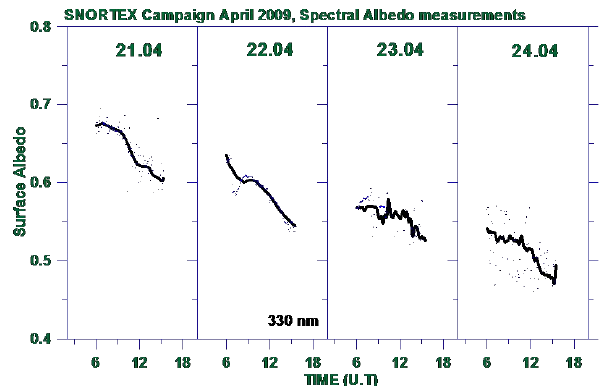
Fig. 3. Snow albedo at 330nm, during 21–24 April, 2009. Blue dots represent 6 min period measurements, and black line time interpo- lated 1 min ratios.